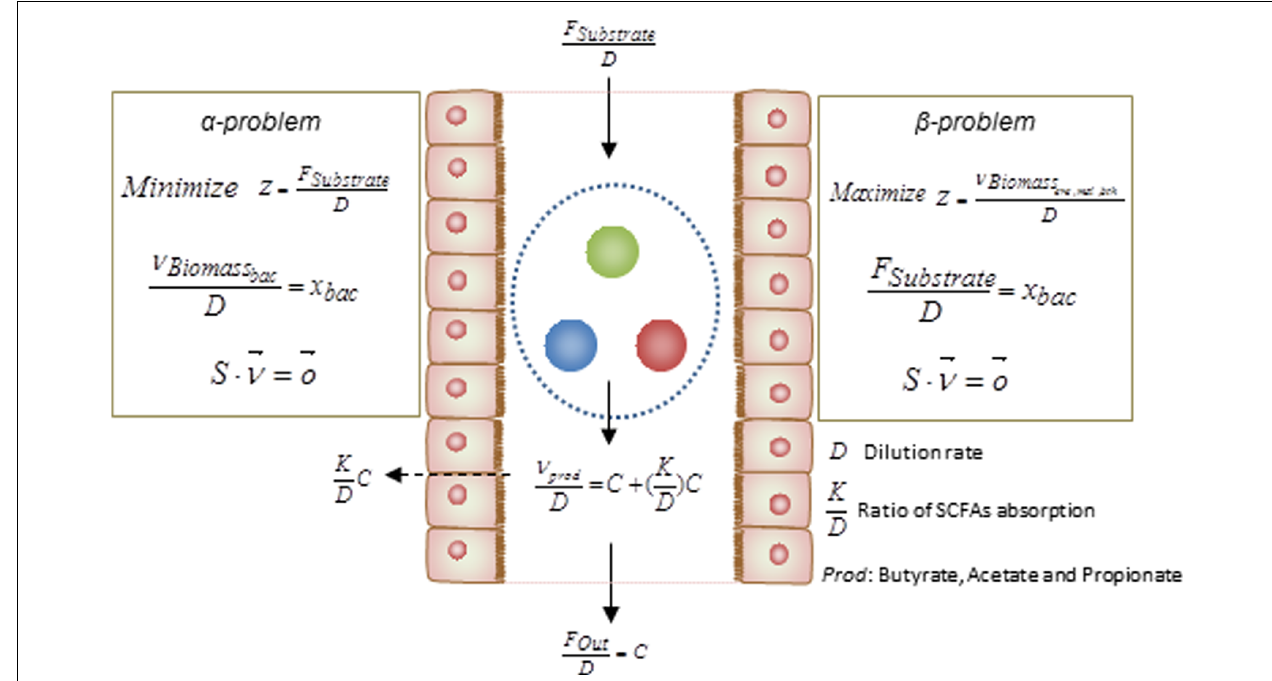
FIGURE 3 | Mathematical formulations for metabolic modeling of the gut microbiota. The formulations of the α - and β -problem have been defined. In the α -problem the abundance of each individual species in the community is well-defined and through minimization for substrate/diet, the profile of